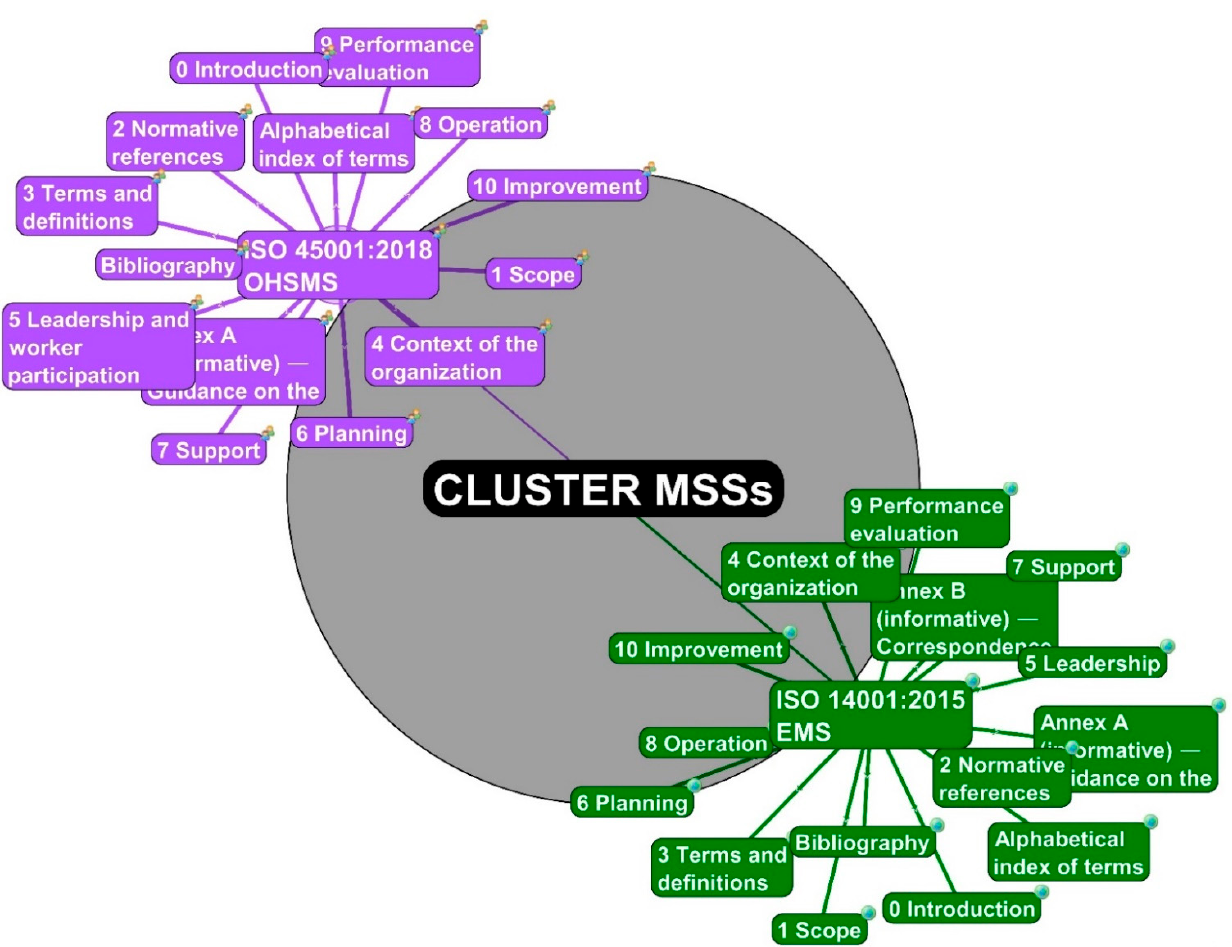
Figure 1. The center units with pairs of standards and their main clauses (source: authors). The color of the individual standards, clauses, and sub-clauses is fixed for easy dif- ferentiation and affiliation determination. The focal point and the standards are logically linked. This procedure of connecting individual points is used throughout the